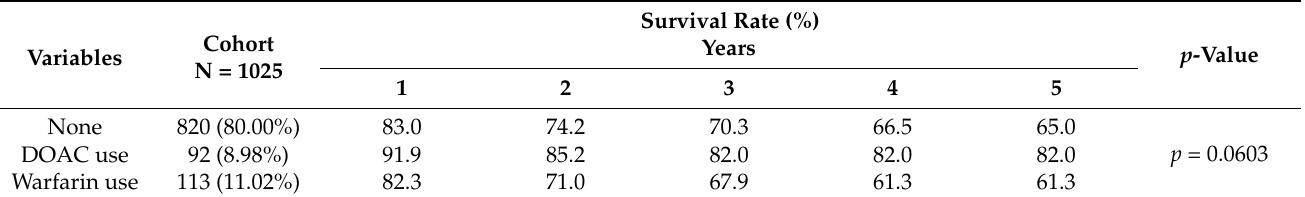
Table 2. Disease-specific survival of DOAC users, warfarin users, and nonusers ( n = 1025).